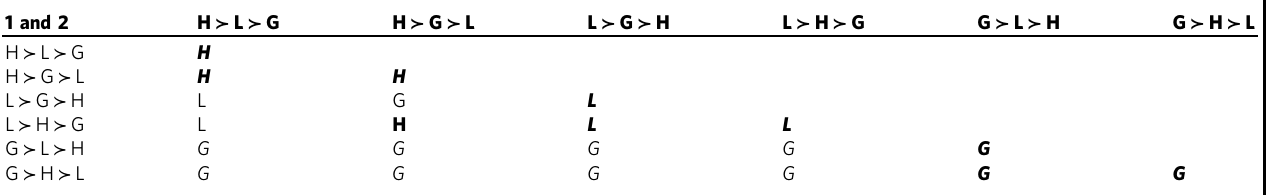
Table 3 Climatic policy outcomes depending on each player ’ s full set of preferences. Availability of geoengineering (G) could lead to high mitigation agreement (H, in bold roman). Symmetric outcomes are omitted for